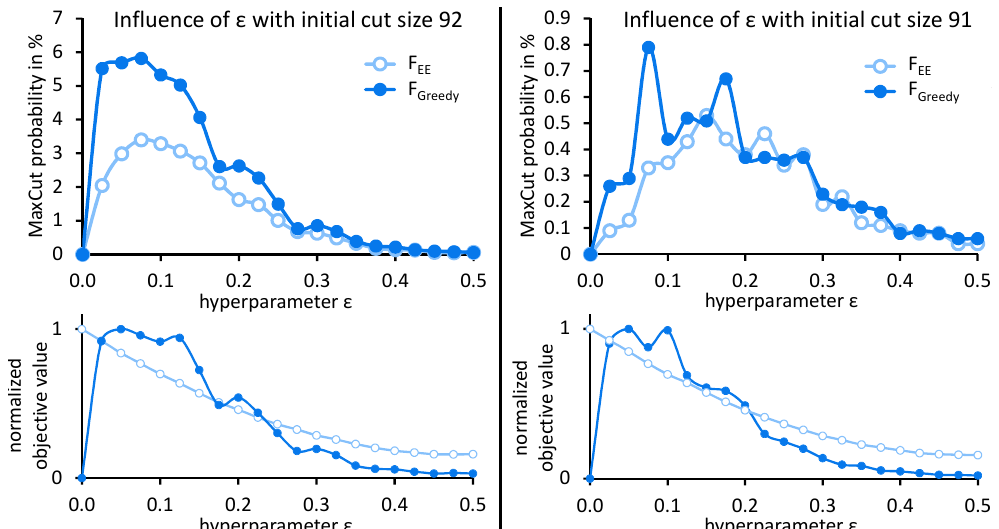
Figure 5. Median probability of sampling the MaxCut of G 12, fc using depth-1 WS-QAOA in 20 runs for each choice of ε and objective functions F EE and F Greedy . Warm-starting was initialized with cuts of size 92 ( left ) and 91 (( right ), bit string 111010111010), respectively (cf. Table 1). Each run was initialized with γ 1 , β 1 chosen uniformly at random from [ 0, π ] . The graphs below depict the normalized median objective values observed after